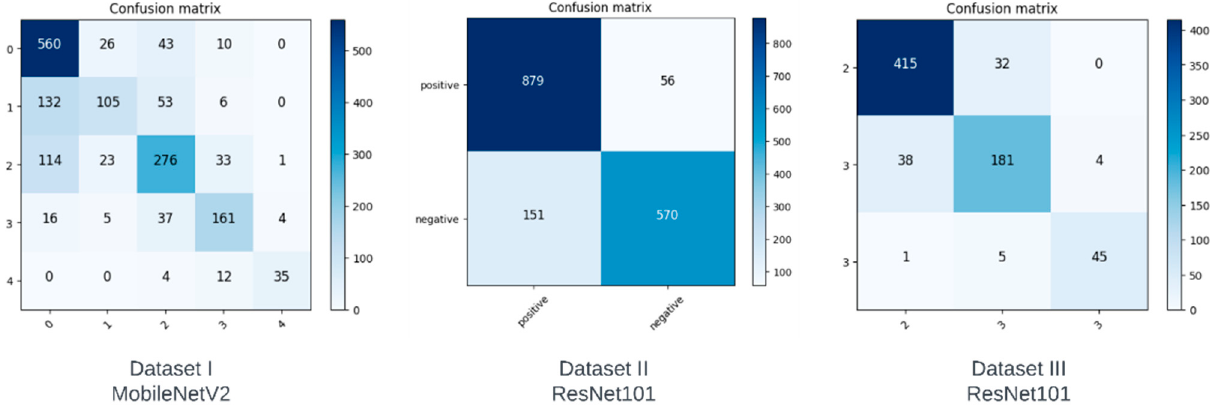
Figure 4. Confusion matrices obtained from our models.